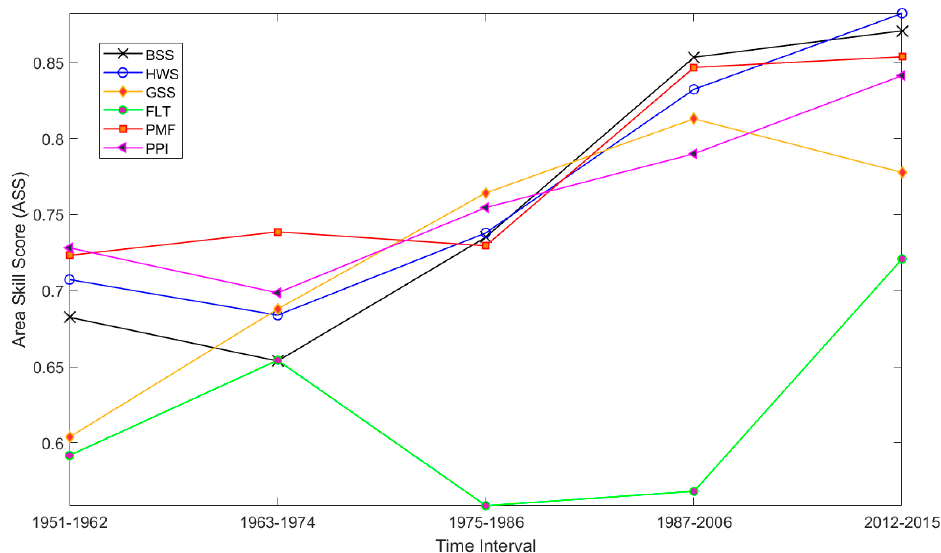
Figure 9. Area Skill Score (ASS) of Molchan error diagram for covariates over different times.